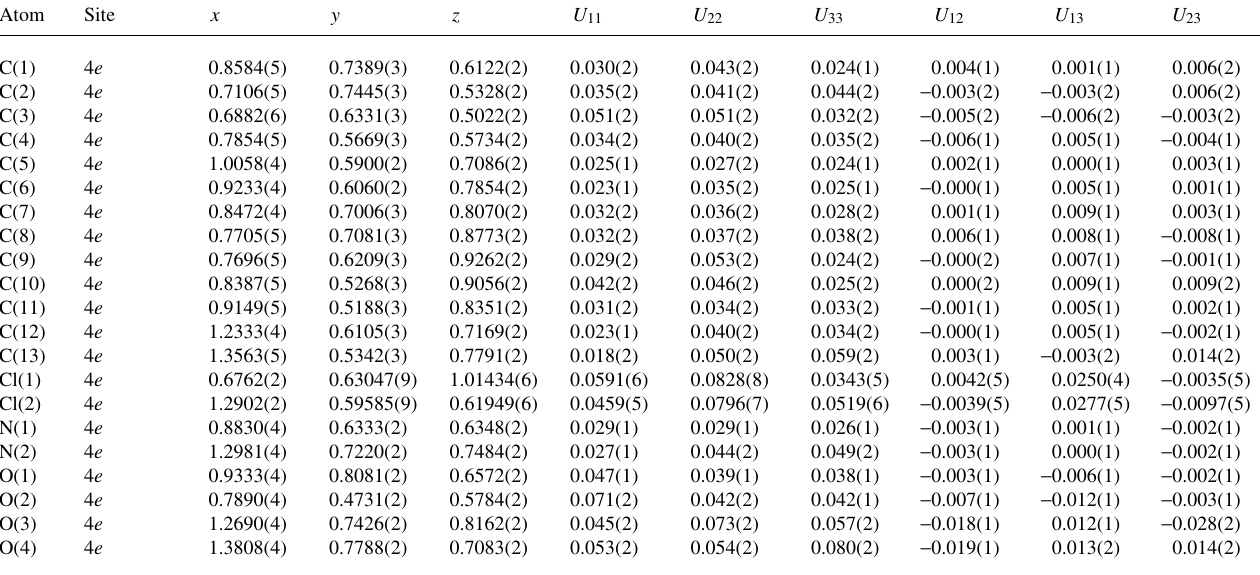
Table 3. Atomic coordinates and displacement parameters (in Å 2 )